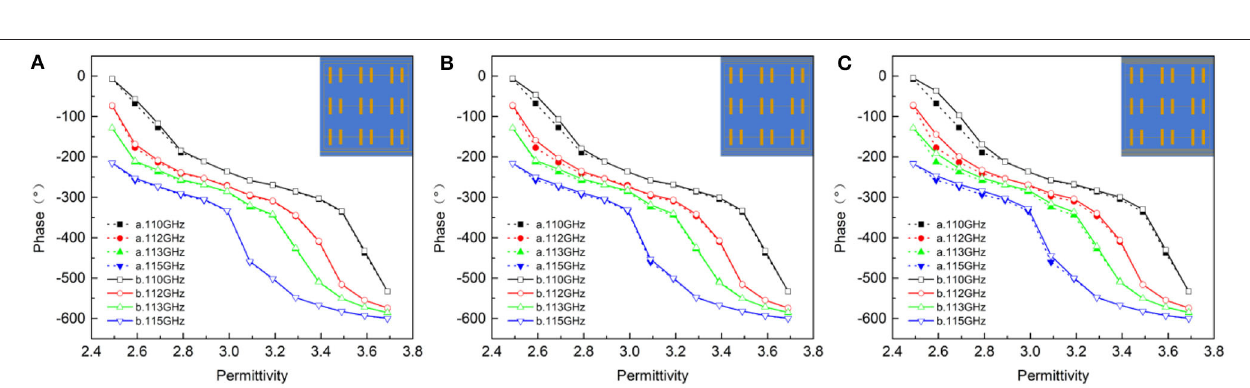
FIGURE 3 | Wiring scheme of the whole antenna (A) and four driving line arrangements of a 3 trunk bias lines (D) . Five trunk bias lines (E) .